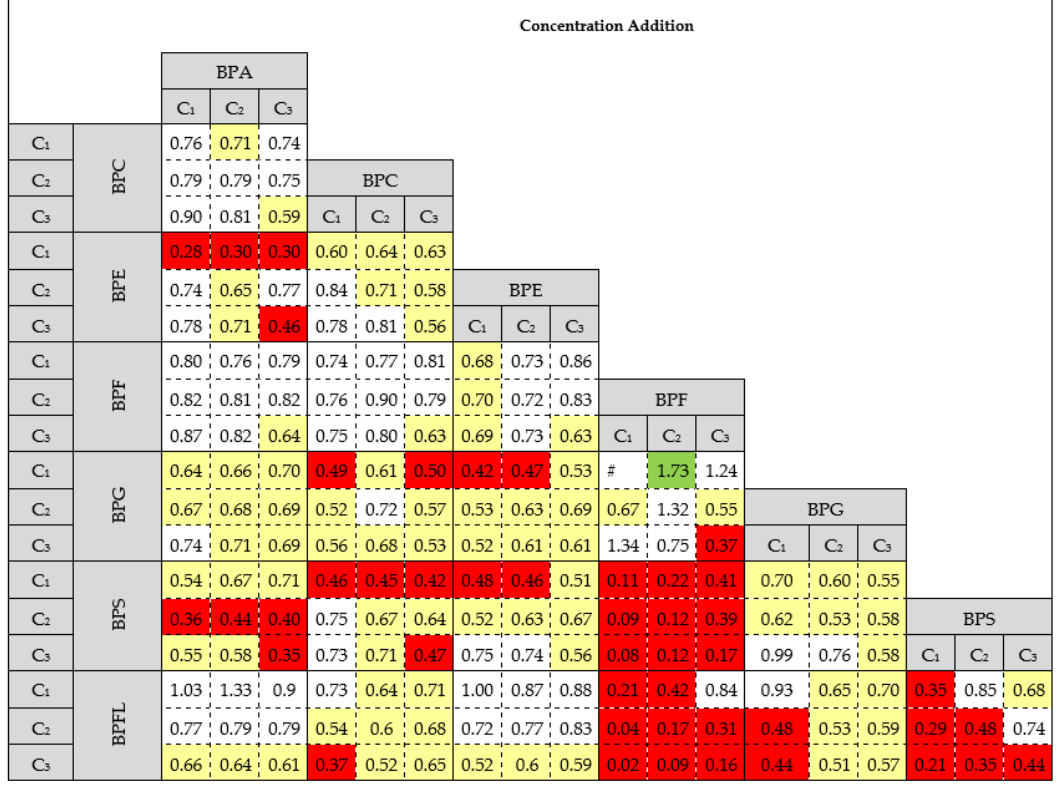
Table 2a. MDR values for bisphenol A analogues binary mixtures toxicity studies performed